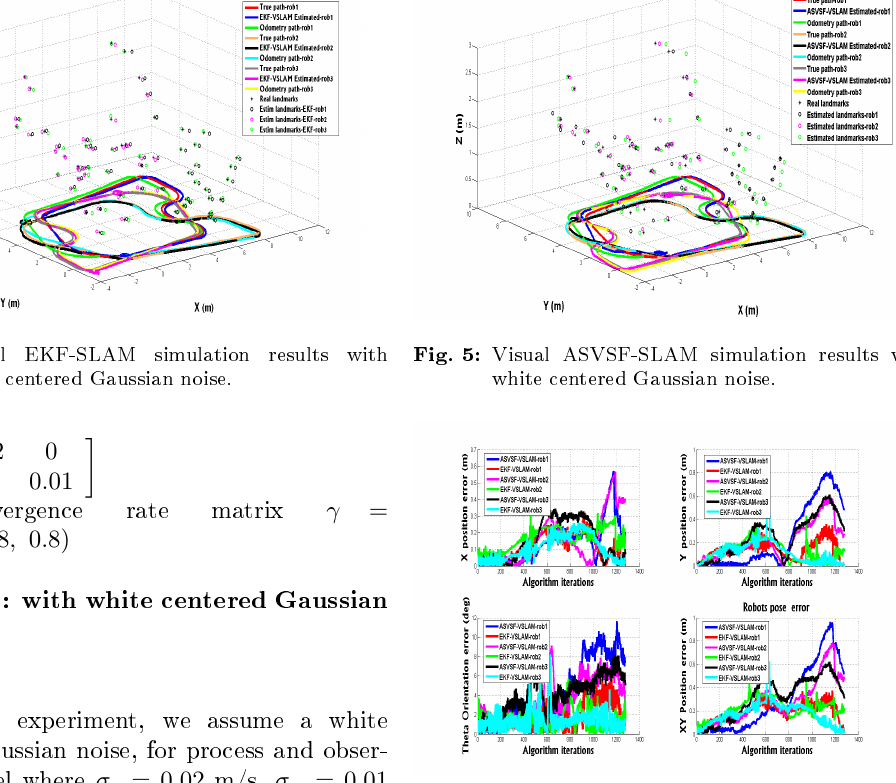
Fig. 6: Position errors of cooperative Visual SLAM with white centered Gaussian